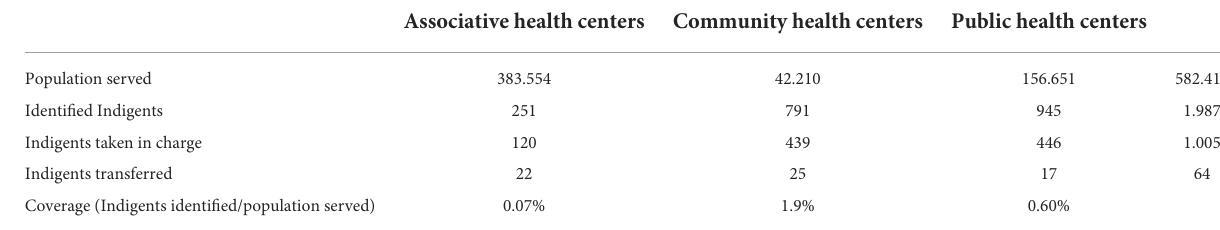
TABLE 1 Health indigent